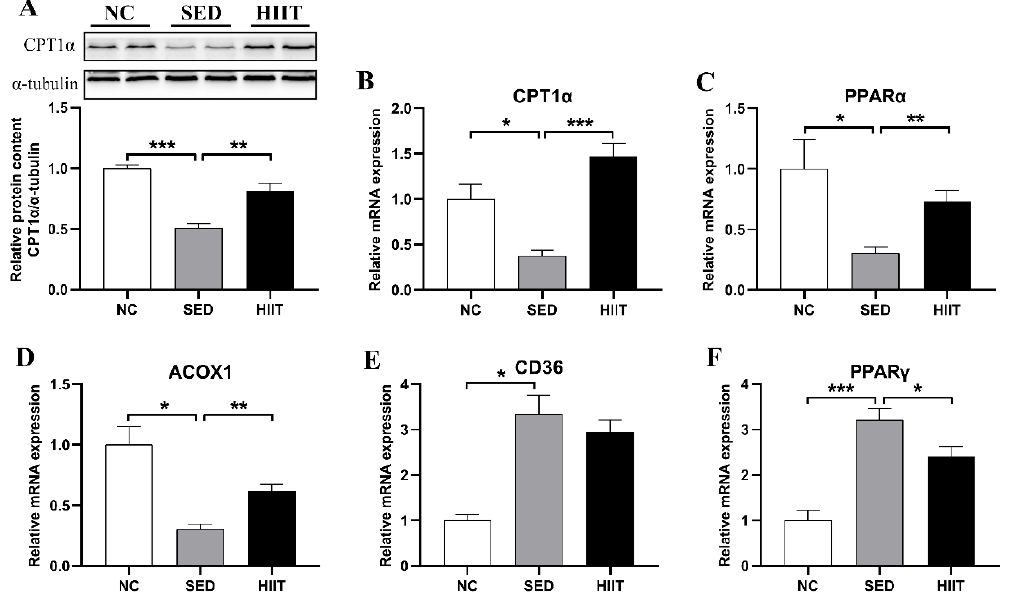
Figure 7. HIIT improves liver lipid metabolism in T2DM mice. ( A ) Protein expression of CPT1α and the internal control α -tubulin in the liver (n = 4 per group). ( B – F ) The mRNA expression levels of CPT1α, PPARα, ACOX1, CD36 , and PPARγ (n = 8 per group). Values are mean ± SEM. * p < 0.05, ** p < 0.01, *** p < 0.001.